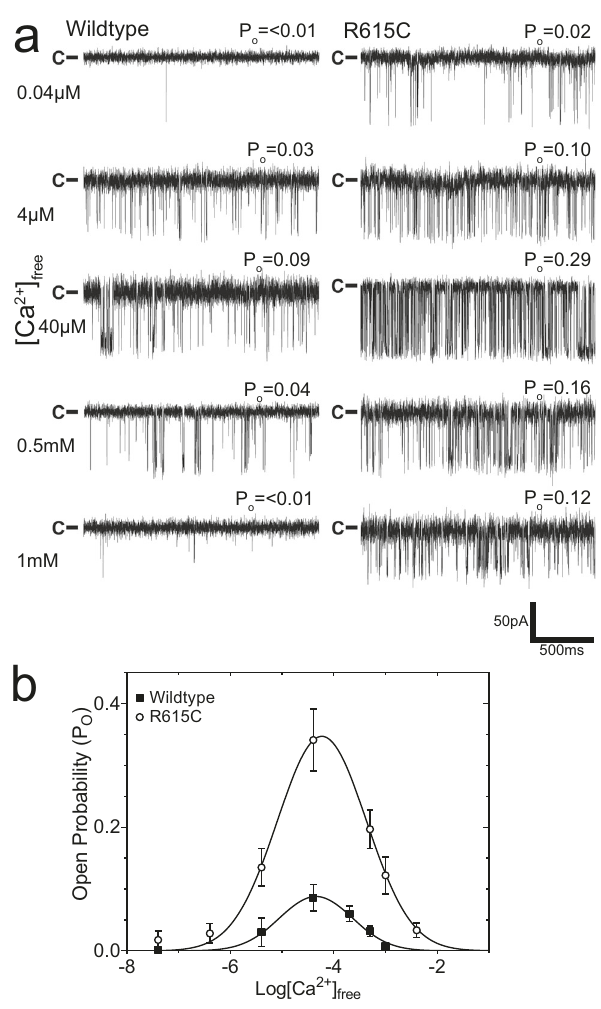
Fig. 1 Pig R615C RyR1 has a higher open probability compared to wild type under various calcium (Ca 2 + ) concentrations. a Representative single-channel traces of WT and R615C pRyR1 at different free Ca 2 + concentrations. b Plots of open probability as a function of free Ca 2 + . Error bars correspond to standard error of the mean ( n = 6 with each independent recording corresponding to a newly incorporated channel from a different liposome). Single-channel recordings were carried out under symmetrical conditions ([ cis ] = [ trans ]) with a constant − 60 mV holding